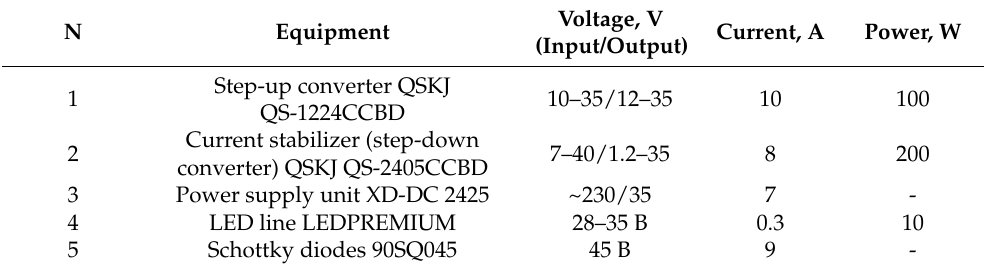
Table 1. Main characteristics of equipment for a lighting system with parallel power supply from photovoltaic modules and the power